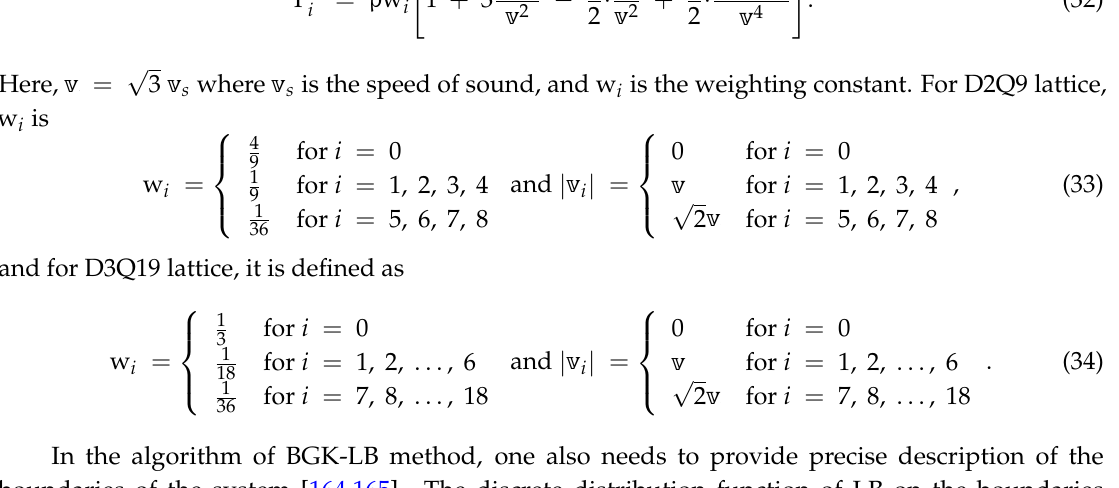
Figure 1. Two typical lattices often used in LB simulations: ( a ) D2Q9; and ( b ) D3Q19.